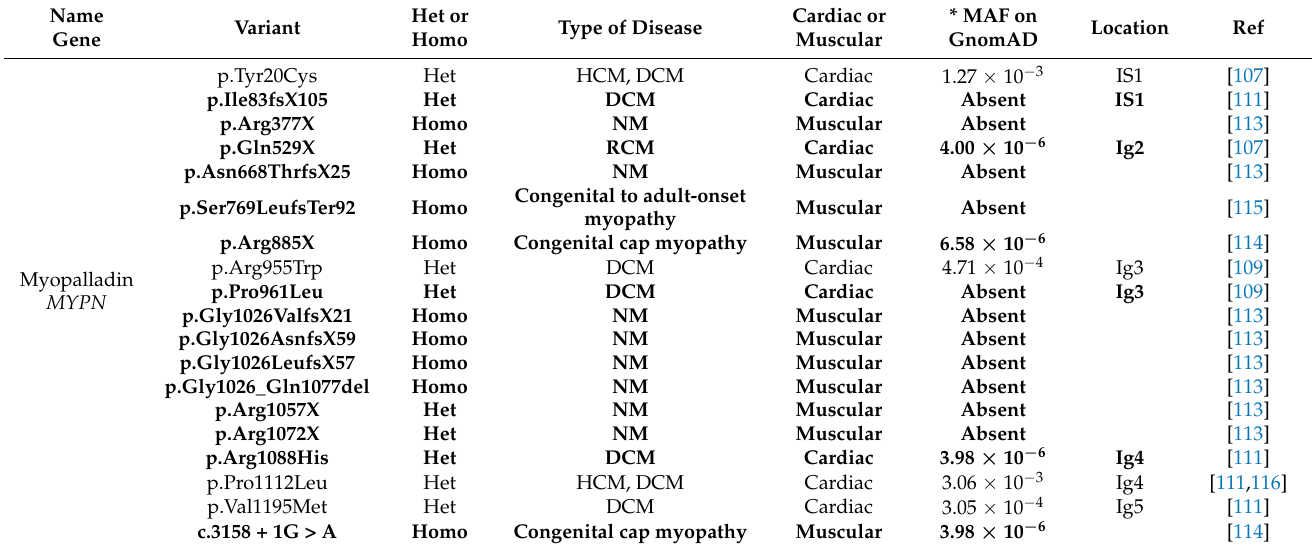
Table 3. Variants in the MYPN gene that have been previously reported in individuals with myopathy or cardiomyopathy. Name